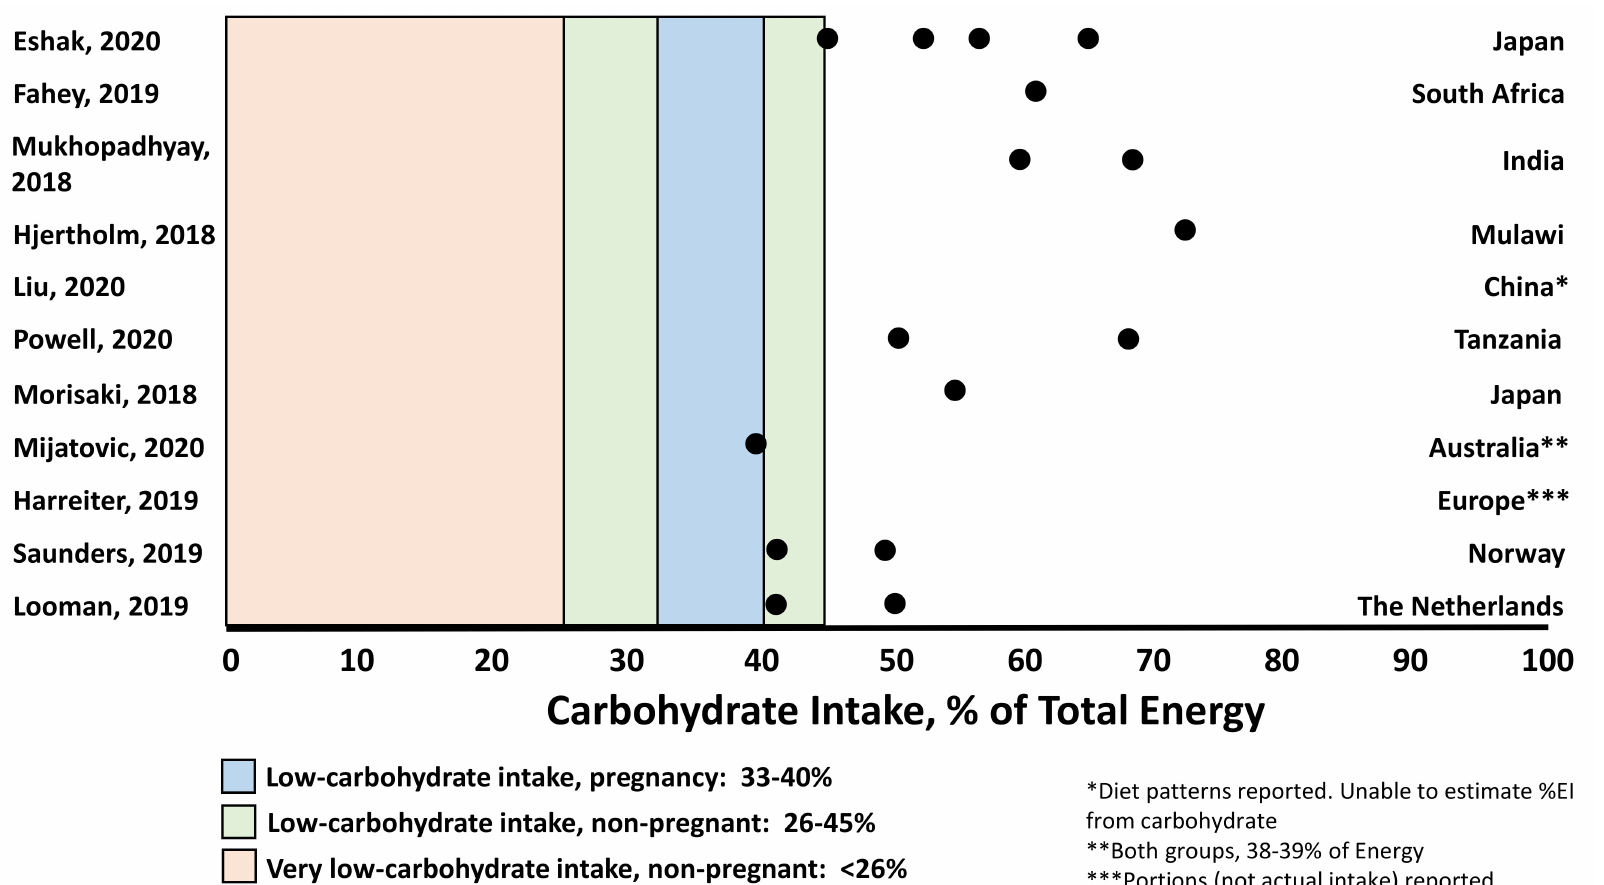
Figure 1. Energy intake from carbohydrate represented across 11 included studies in the context of definitions of low-carbohydrate intake within [4] and outside [41] of pregnancy (American Diabetes Association consensus statement). Unless reported in Tables 1–4, energy from carbohydrate was calculated based on 4 kcal/g as a percentage of total EI. (1 kcal = 4.184